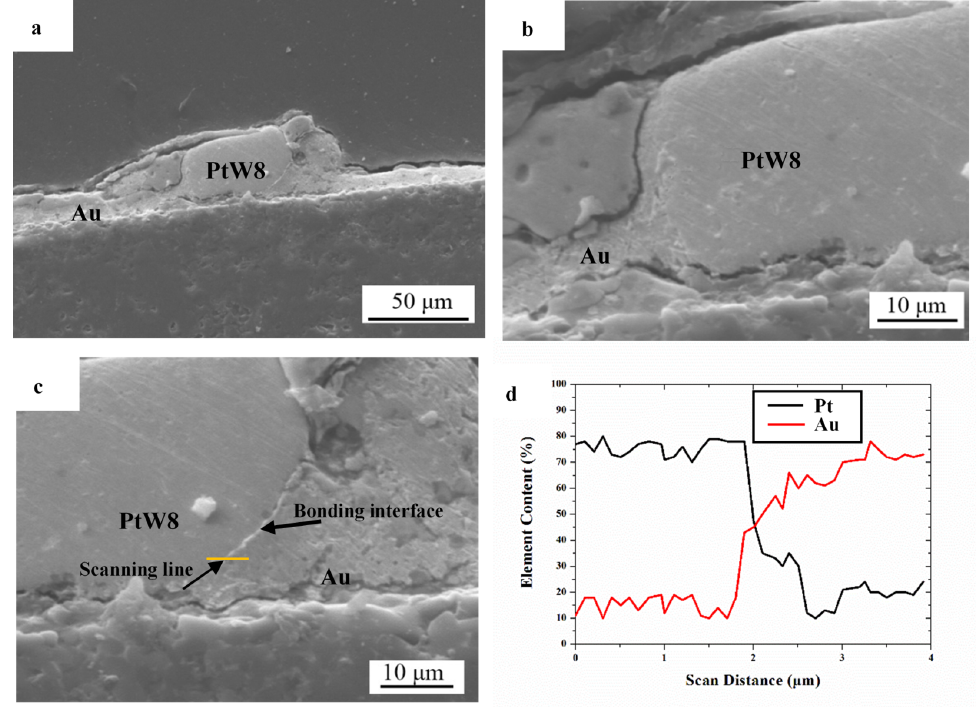
Figure 7. ( a ) SEM cross-sectional images of joints, ( b ) enlarged view on the left side of the cross-section, ( c ) enlarged view on the right side of the cross-section, and ( d ) chemical elements analysis of the cross-section of the bonding interface.